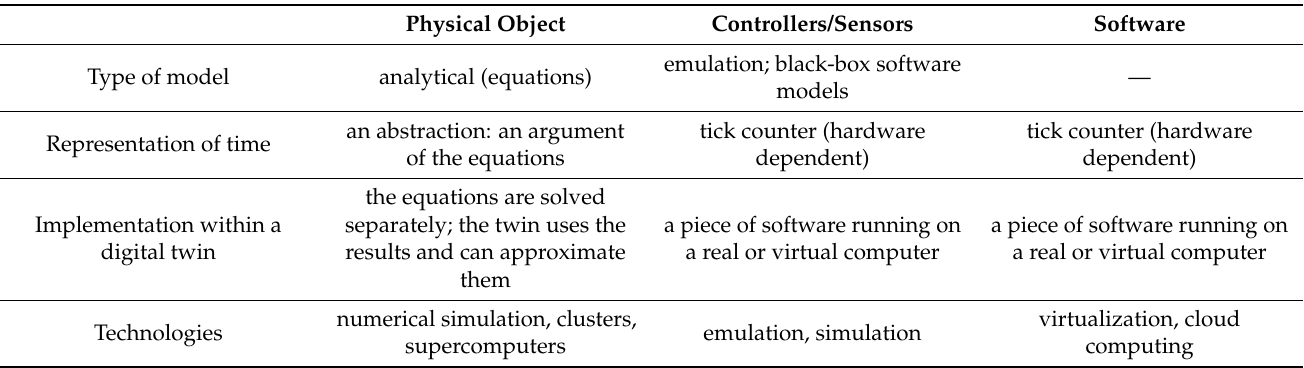
Table 2. The principles of CPS digital twin